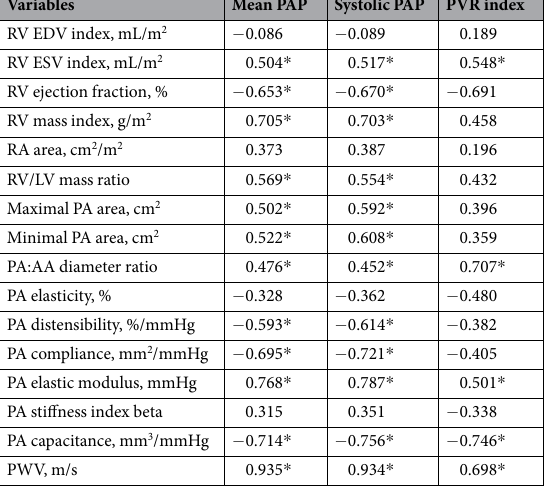
Table 3. Correlation between RV function, PA Stiffness Parameters and Pulmonary Pressures/Resistancein Patients with COPD. Abbreviations: AA, ascending aorta; COPD, chronic obstructive pulmonary disease; LV, left ventricle; RA, right atrium; RV, right ventricle; RVEDV, right ventricular end-diastolic volume; RVESV, right ventricular end-systolic volume; PA, pulmonary artery; PAP, pulmonary artery pressure; PVR, pulmonary vascular resistance; PWV, pulse wave velocity; IQR, interquartile range; SD, standard deviation. * Statistical significance: p <